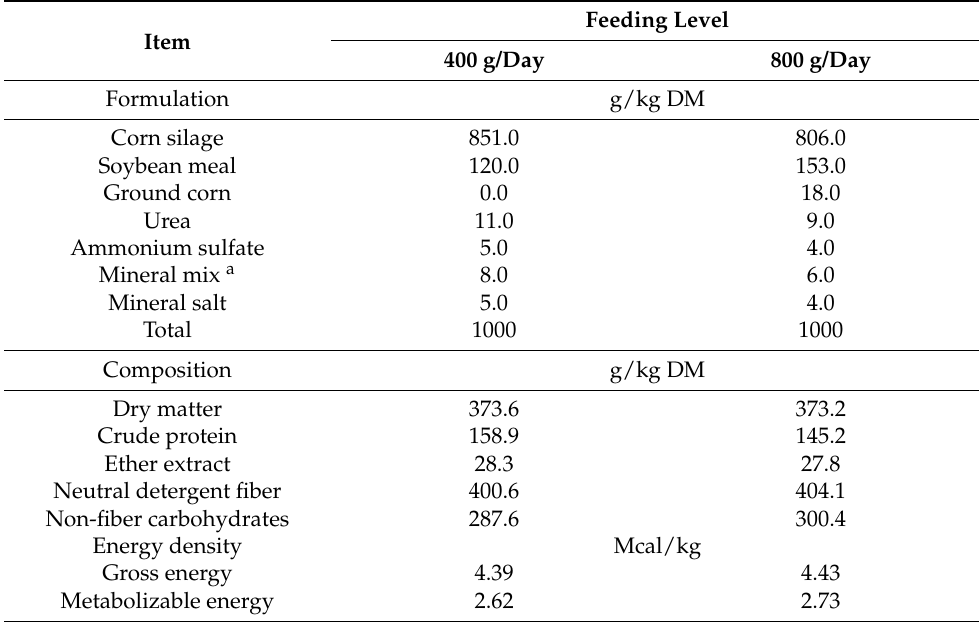
Table 1. Ingredients and chemical composition of the experimental